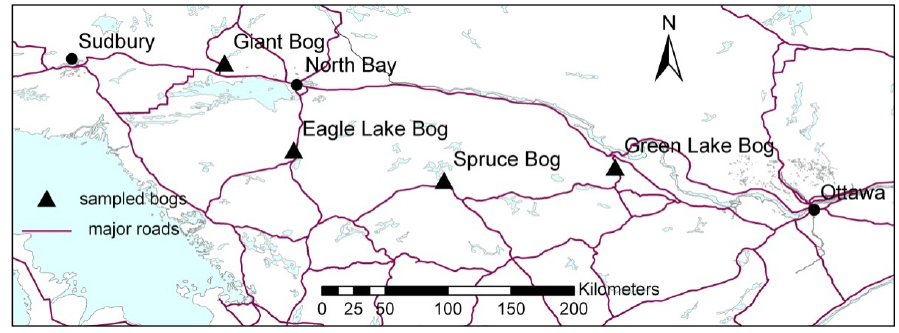
Figure 1. Locations of sampled peat bogs in Ontario,